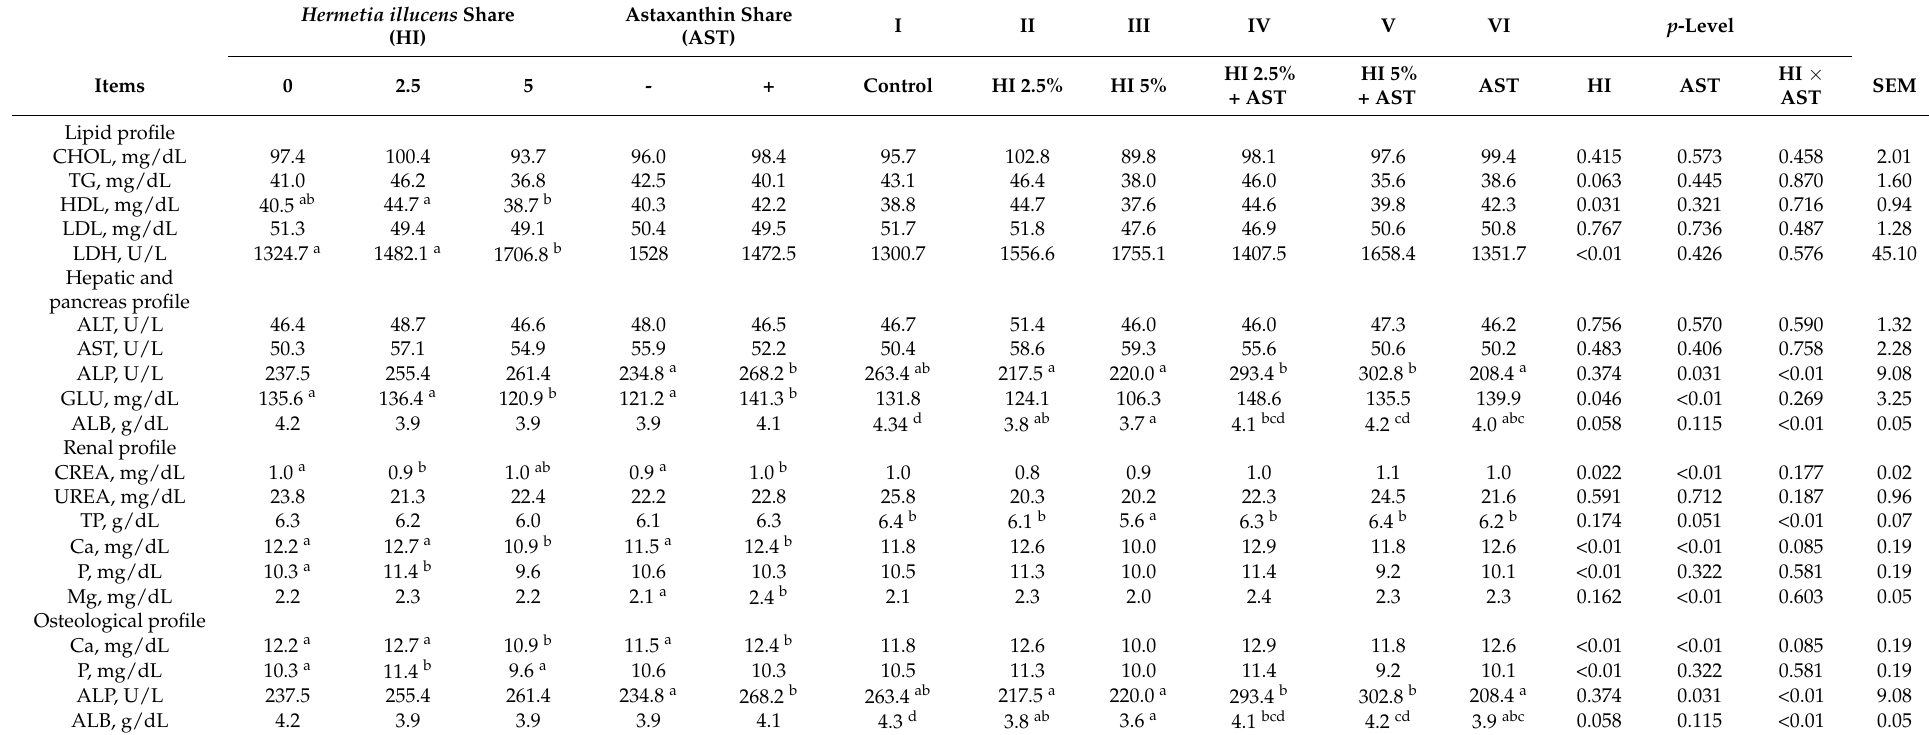
Table 4. Effect of Hermetia illucens meal share and astaxanthin presence in feed on the biochemical indices of piglets’